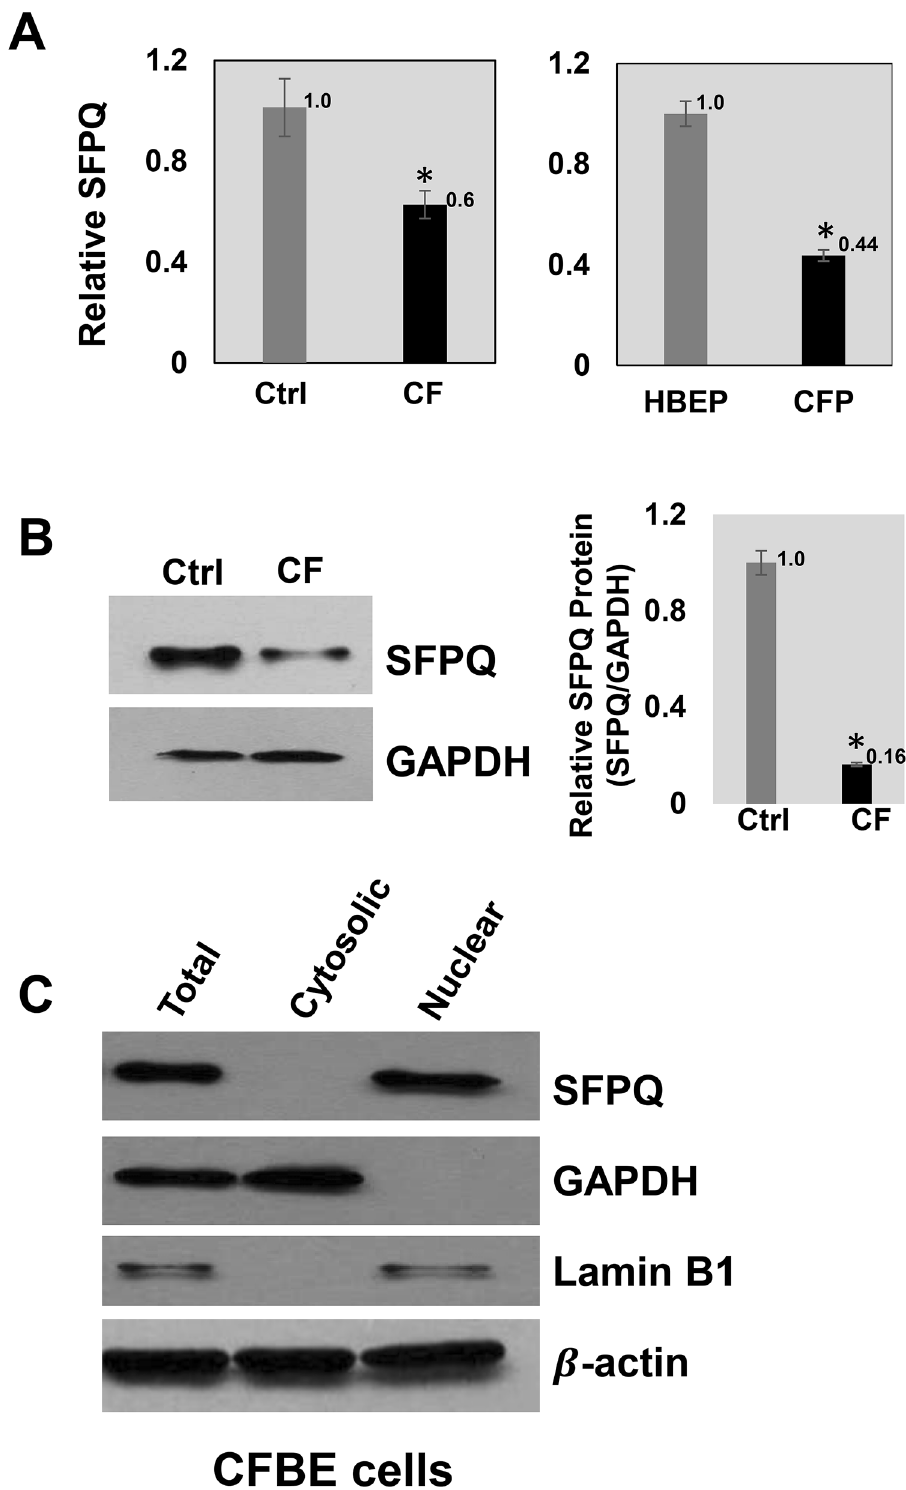
Figure 1. Expression of SFPQ in CF lung cells. ( A ) SFPQ expression was analyzed in RNA isolated from F508del-CFTR CF lung epithelial cell line (CFBE41o − ) compared to respective control cell line (16HBE14o − ), and from CF lung parenchyma tissues, and matched control tissues (n = 3, each group). GAPDH was used as an endogenous control. ( B ) SFPQ protein was analyzed by immunoblot in CF and control cells and normalized to GAPDH protein levels. ( C ) Localization of SFPQ protein was analyzed by immunoblot in CFBE cells containing the F508del-CFTR mutation for SFPQ protein localization. The full-length blots are presented in Supplementary materials (Figure S1). The data are representative of two or more independent